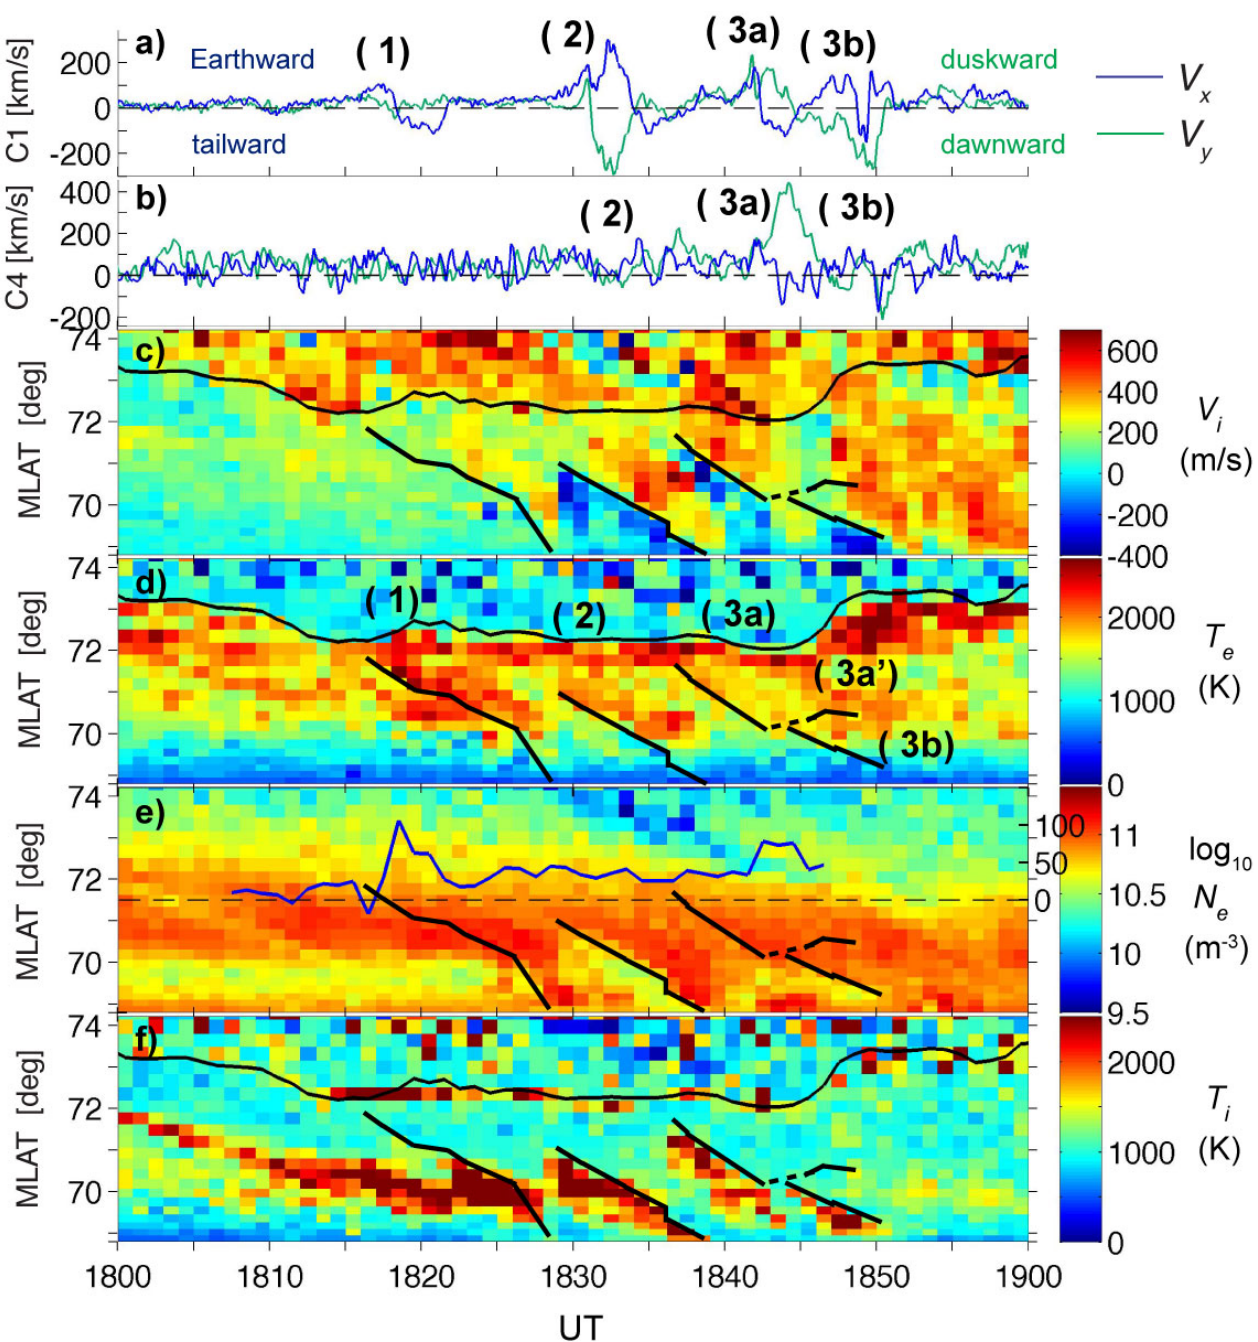
Fig. 7. Cluster and EISCAT VHF data from the time interval 18:00–19:00UT. (a) and (b) The same as in panels (a) and (b) in Fig. 4, but without V z component. (c) – (f) Line-of-sight ion velocity ( V i , positive towards the radar), electron temperature ( T e ), electron density ( N e ), and ion temperature ( T i ). Black continuous line in panels (c) , (d) and (f) marks the polar cap boundary. Blue line in panel (e) is the reconnection electric field estimate. Note the separate scale (mVm − 1 ) on the right for the E r . Velocity shears associated with the auroral streamers are marked by black thick equatorward descending lines in panels (c) – (f) . The dashed portion marks the appearance of streamer 3b equatorward of